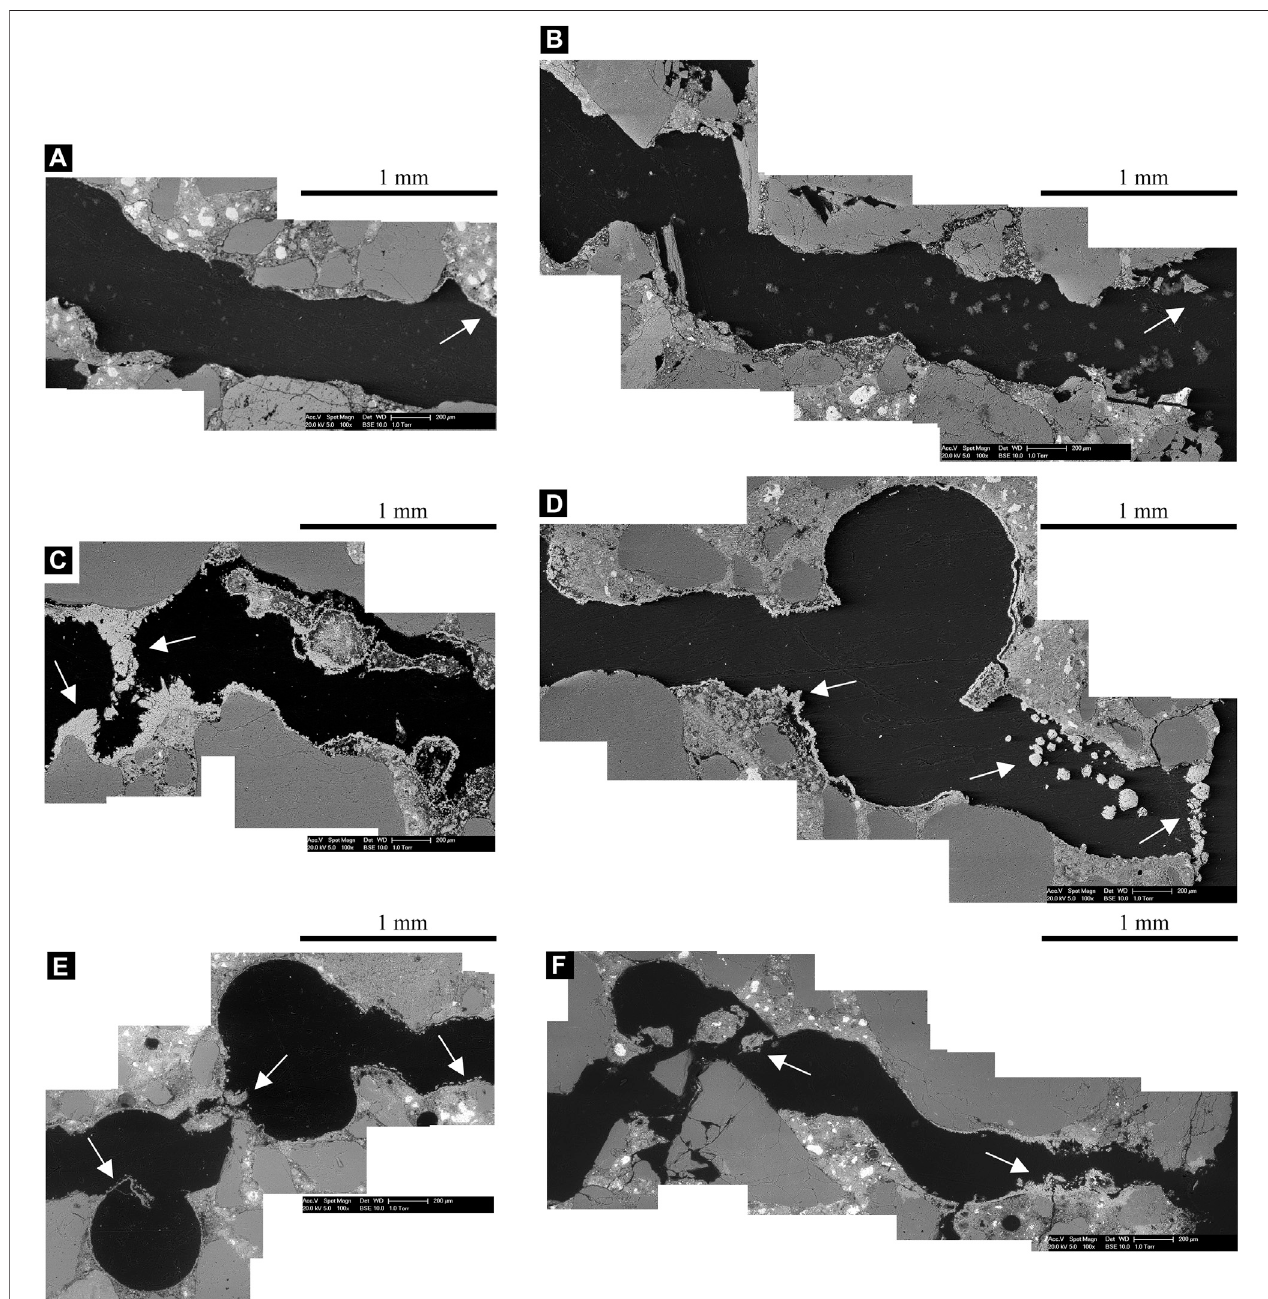
FIGURE 8 | Polished sections perpendicular to the crack under ESEM/BSE of (A,B) Ctrl-6m plain mortar, (C,D) PLA-6m and (E,F) AKD-6m specimens (precipitates are indicated by white arrows). B , D and F are representative for the crack mouth of each specimen. A , C and E are micrographs taken at around 20 mm depth perpendicularly to the